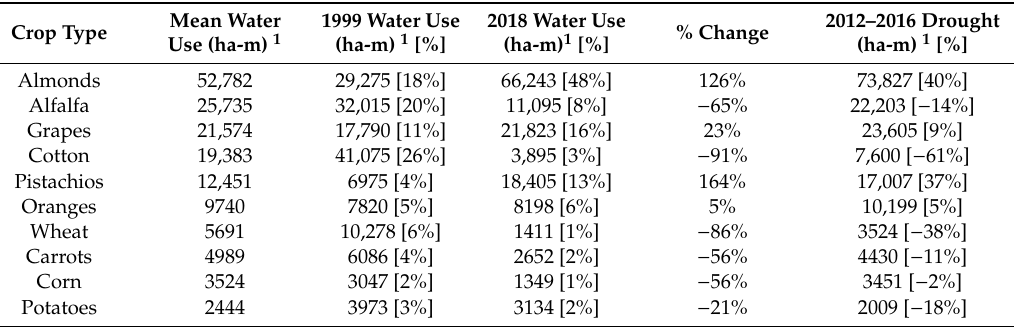
Table 8. Summary statistics of the crop water use estimates for the top 10 major crops in Kern County Figure 1999. to 2018 ordered by mean including: (1) the mean of the 1999–2018 period, (2) the crop area in 1999 and the percentage of the total crop area, (3) the crop area in 2018 and the percentage of the total crop area, (4) the change in crop area between 1999 and 2018, and (5) the mean crop area during the 2012–2016 California drought and percent deviation from the mean.